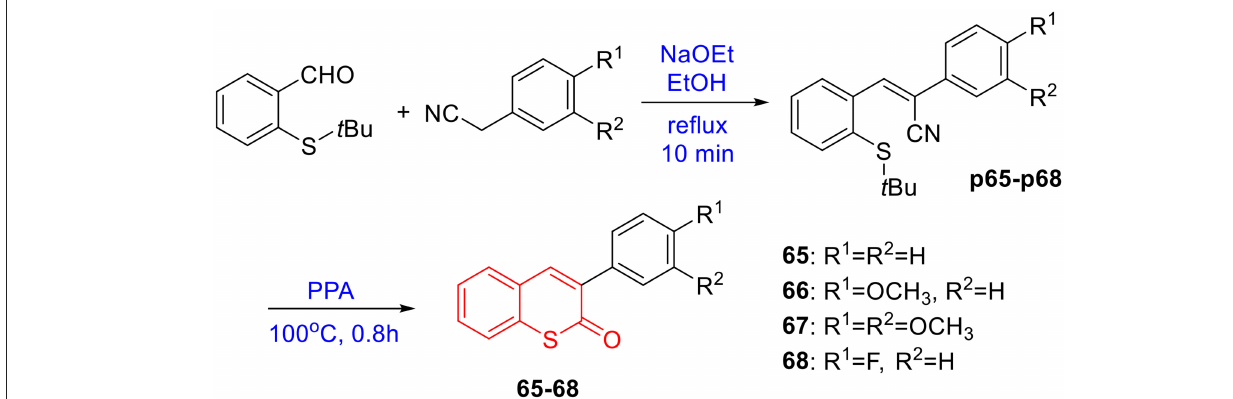
SCHEME 5 | Synthesis of thiocoumarin 65 – 68 .